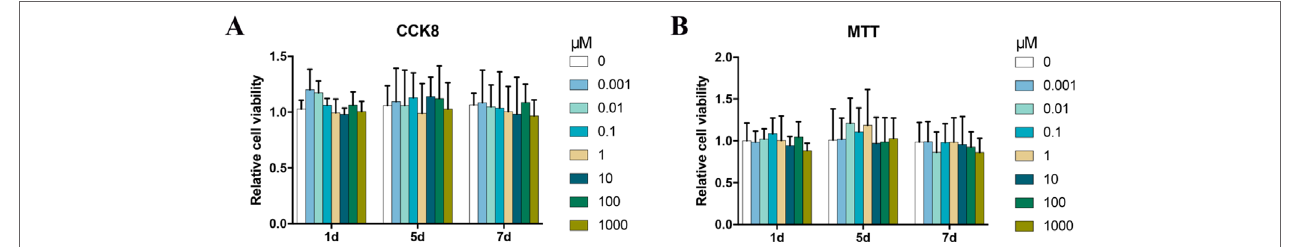
FIGURE 1 | Effects of Bergenin on cell activity in human bone marrow mesenchymal stem cells (BMSCs). (A) The effects of Bergenin on BMSC viability were detected using Cell Counting Kit-8. (B) The effects of Bergenin on BMSC viability were detected using MTT assay. Data are expressed as the mean ± standard deviation (SD), n = 3. * P < 0.05 vs. BMSCs without